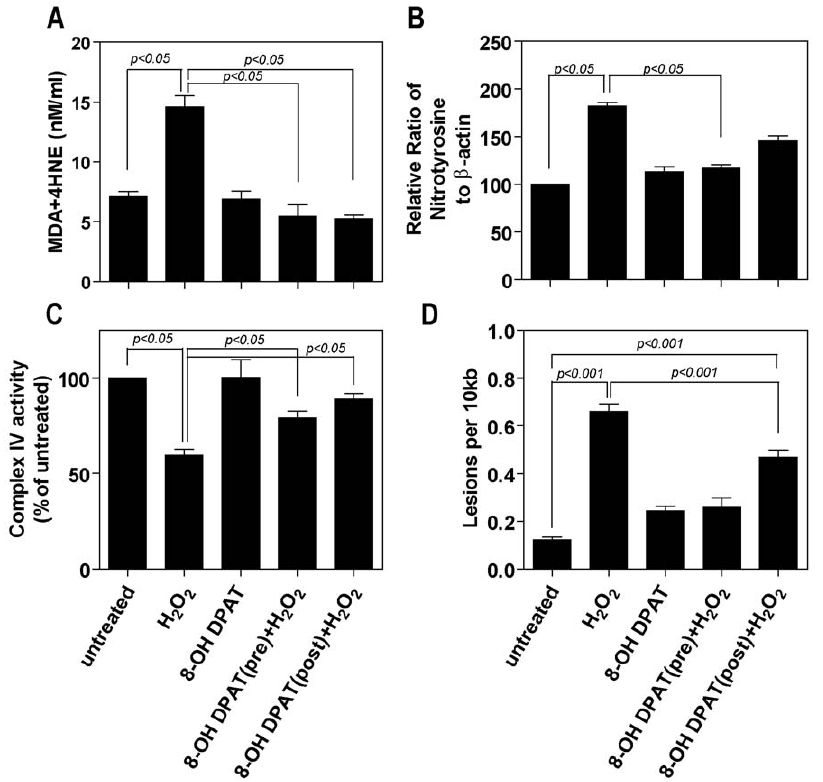
Figure 3. 8-OH DPAT reduces lipid peroxidation and peroxynitrite accumulation and protects against mitochondrial damage in cultured RPE cells exposed to H 2 O 2 . Cells were exposed to H 2 O 2 (200 m M) for 1 hour and either pre-or post treated with 8-OH DPAT (10 m M) for 24 hours. In the case of pretreatment all measurements were made 24 hr after H 2 O 2 and for post treatment 8-OH DPAT was added immediately following H 2 O 2 exposure. A - The level of lipid peroxides (4HNE/MDA) was determined using a commercially available kit from OxisResearch. B – Nitrotyrosine levels were assessed by Western blotting using a polyclonal antibody and band intensities were normalized against b -actin. C - Cytochome c oxidase levels were determined using a Complex IV ELISA assay. D - Mitochondrial DNA damage was analyzed as previously described using the long chain PCR reaction. Data represent the mean of three experiments.